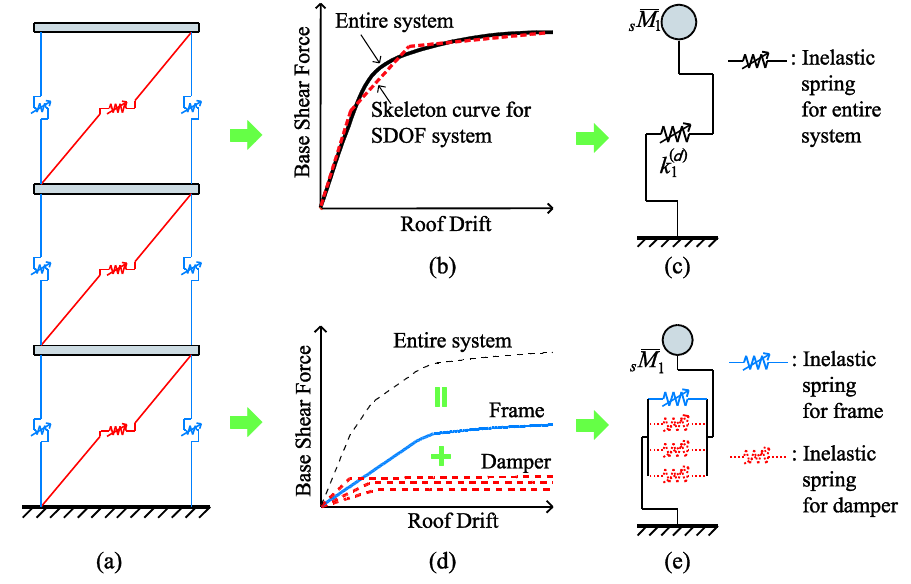
Figure 1. A multi-story frame with steel hysteretic dampers: ( a ) a shear frame with dampers; ( b ) a single skeleton curve; ( c ) an equivalent inelastic SDOF system with a single inelastic spring; ( d ) multi-skeleton curves; and ( e ) an equivalent inelastic SDOF system with inelastic multi-springs.